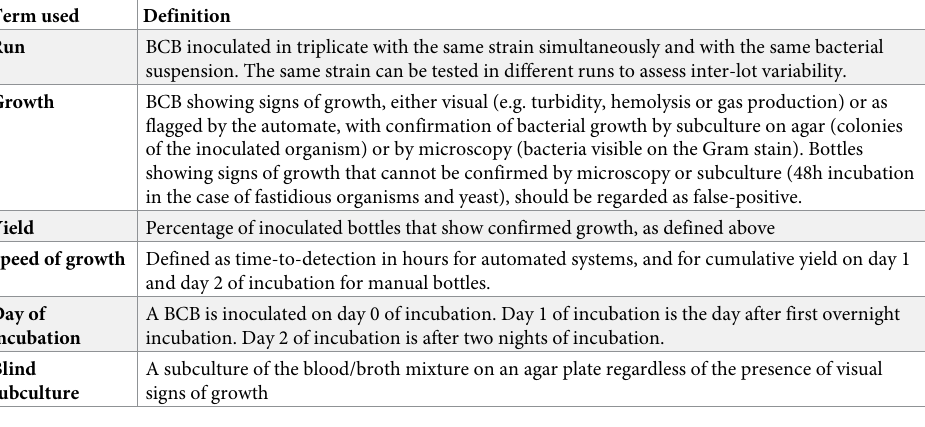
Table 1. Definitions of terms used in the protocol proposal. Term used Definition Run BCB inoculated in triplicate with the same strain simultaneously and with the same bacterial suspension. The same strain can be tested in different runs to assess inter-lot variability. Growth BCB showing signs of growth, either visual (e.g. turbidity, hemolysis or gas production) or as flagged by the automate, with confirmation of bacterial growth by subculture on agar (colonies of the inoculated organism) or by microscopy (bacteria visible on the Gram stain). Bottles showing signs of growth that cannot be confirmed by microscopy or subculture (48h incubation in the case of fastidious organisms and yeast), should be regarded as false-positive. Yield Percentage of inoculated bottles that show confirmed growth, as defined above Speed of growth Defined as time-to-detection in hours for automated systems, and for cumulative yield on day 1 and day 2 of incubation for manual bottles. Day of incubation Blind